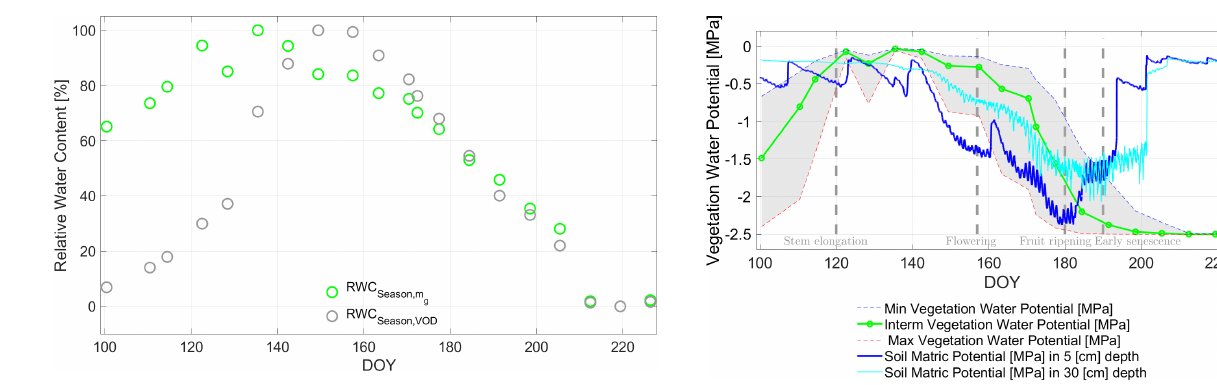
Figure 12. Comparison of in situ-based soil matric (both blueish curves) and radiometer-based vegetation water (solid green and small dashed curves) potentials (SMP [MPa] and VWP [MPa]) in the growing period of 2017 along days of year (DOY) at the winter wheat field. The gray-shaded area indicates the potential variabil- ity of the estimated VWP depending on the relationship applied in Eq. (3) (cf. Fig. 3). Vertical dashed lines indicate major phenologi- cal phases of the winter